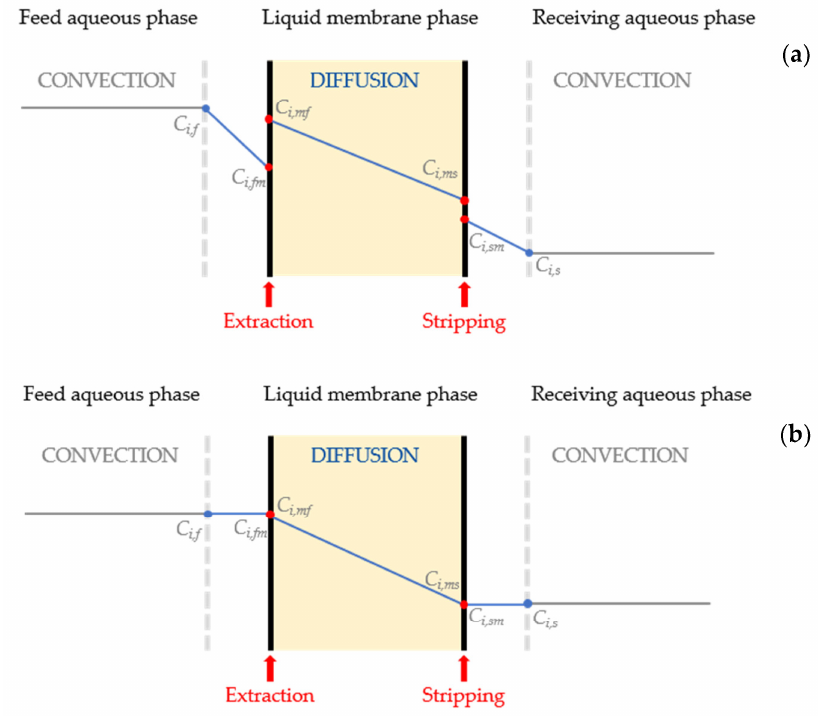
Figure 1. Concentration profile for the transport of the different monomers. ( a ) considering the three different resistances (diffusion on feed and stripping sides and through the membrane). ( b ) consider- ing the diffusion through the liquid membrane as the limiting